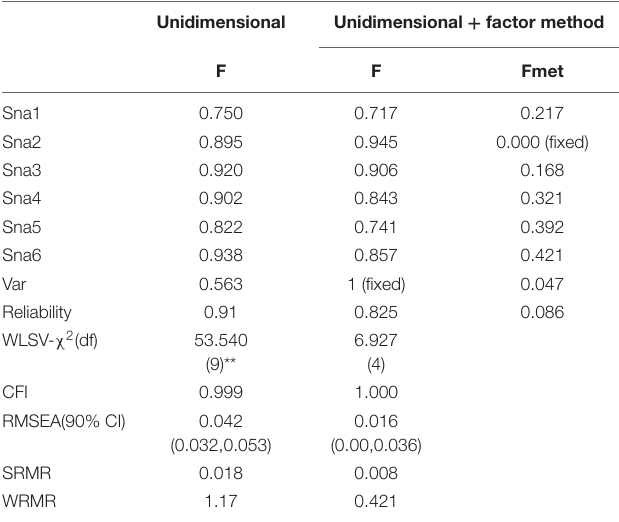
TABLE 4 | Unidimensional and unidimensional with method factor